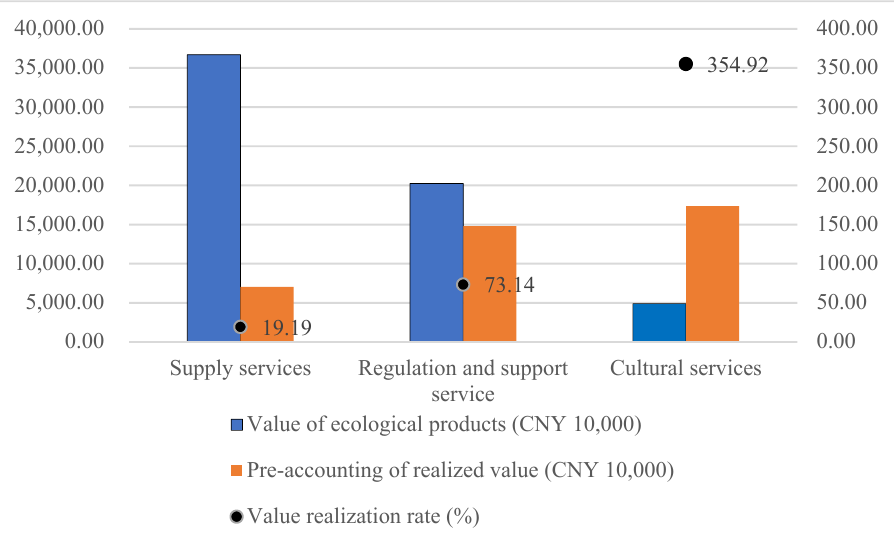
Figure 4. Ecoproduct value realization rate.